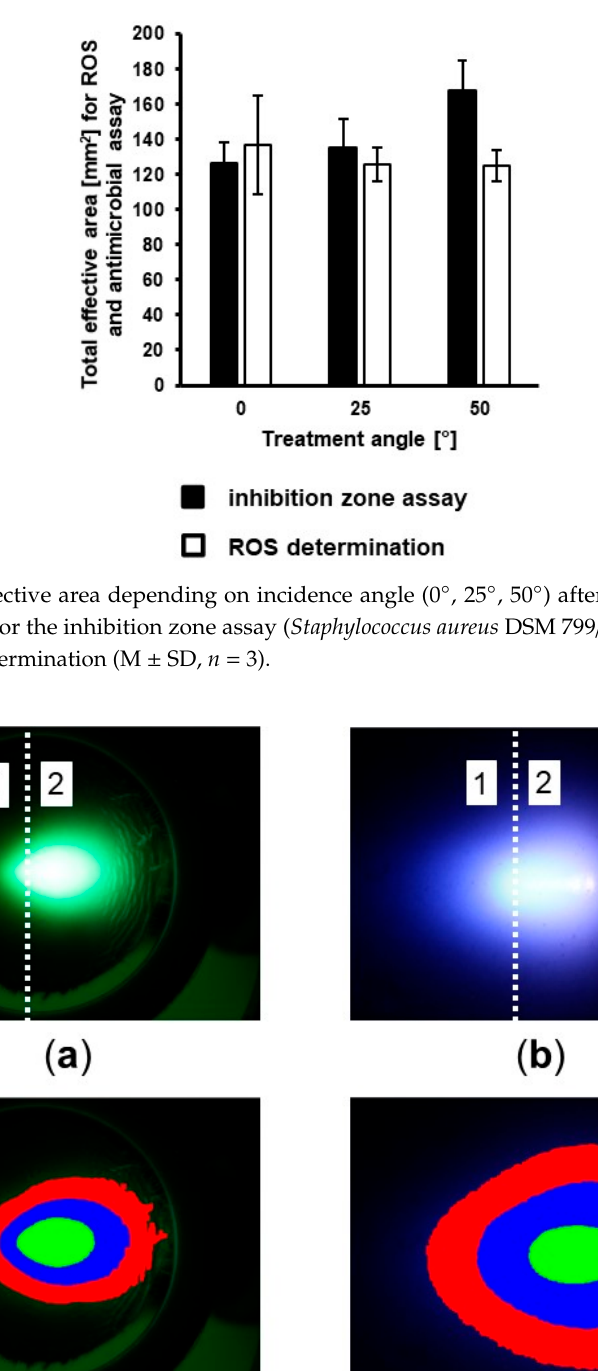
Figure 10. ( a ) VUV and ( b ) UV irradiation profile for an incidence angle of 60° (side 1: inclination of the kINPen ® MED- β as shown in Figure 2c, side 2: area with plasma plume propagation) and ( c , d ) analyzed according to primary (green), secondary (blue) and peripheral (red) zones.